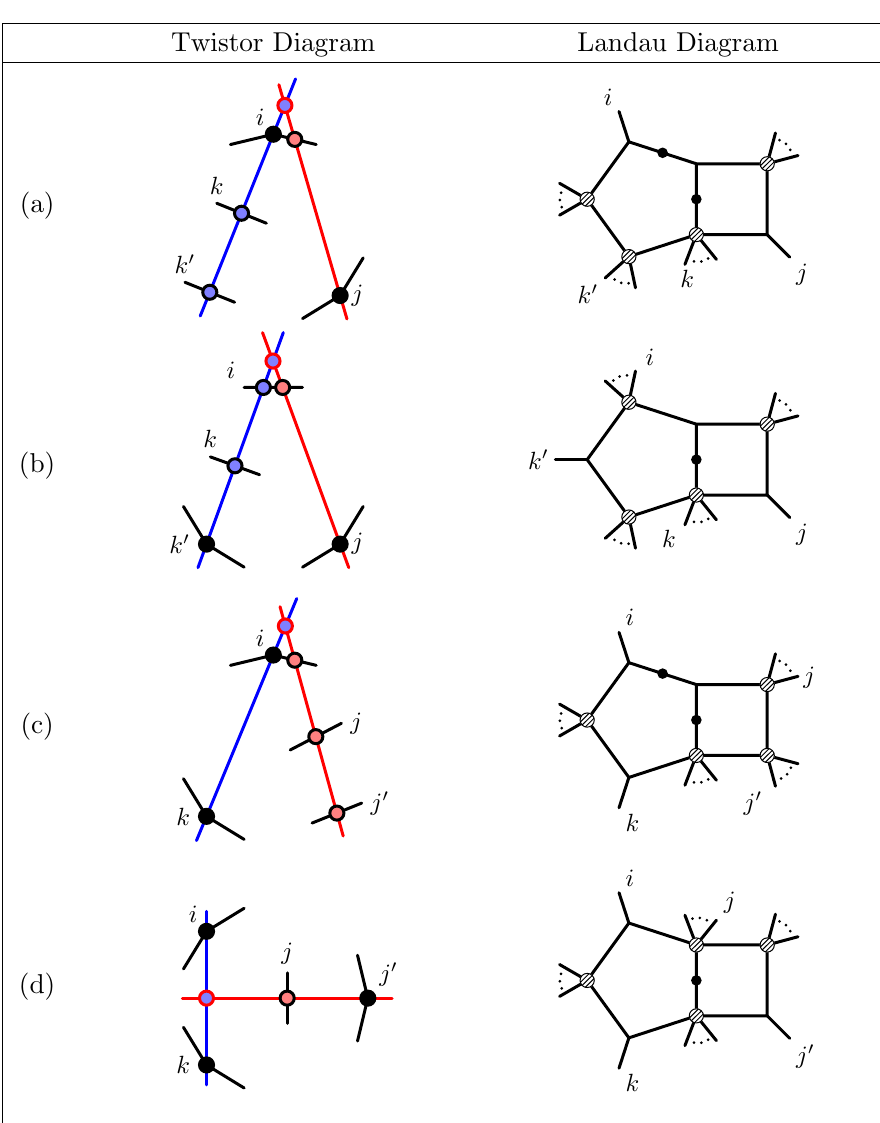
Table 2 . The twistor and Landau diagrams describing types of (resolved, in (a) and (c))